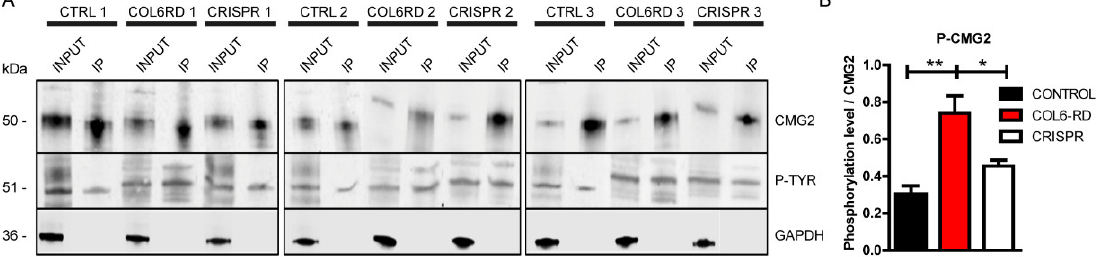
Figure 5. CMG2 phosphorylation levels are increased in COL6-RD patient-derived fibroblasts. ( A ) Western blotting for CMG2 receptor and its tyrosine-phosphorylated form after immunoprecipitation (IP) of control, COL6-RD patient, and CRISPR-treated COL6-RD patient-derived fibroblasts. Blots of equally loaded protein extracts prior to IP (input) are also shown. The marker GAPDH is used as the loading control. ( B ) Total quantification of the IP phosphorylated form of CMG2 versus IP CMG2 from the three phenotypes is shown. Data are expressed as the mean ± SEM; n = 3; independent primary cell preparations were used for all panels. * p < 0.05, ** p < 0.01; one-way ANOVA/Bonferroni’s multiple comparison test.